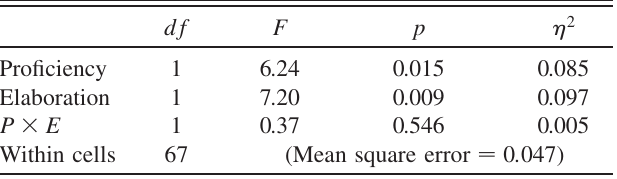
TABLE IX. ANOVAwith magnetism problem-sorting score as